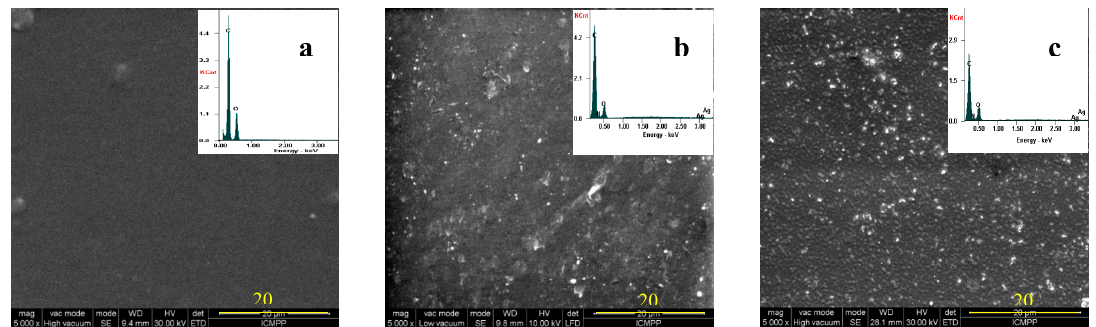
Figure 7. SEM images and Energy Dispersive Spectroscopy (EDAX) spectra of: ( a ) P0; ( b ) P1; ( c ) P2.